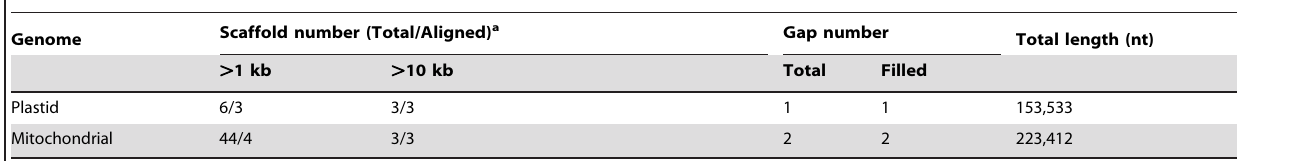
Table 6. Summary of de novo assembly results.